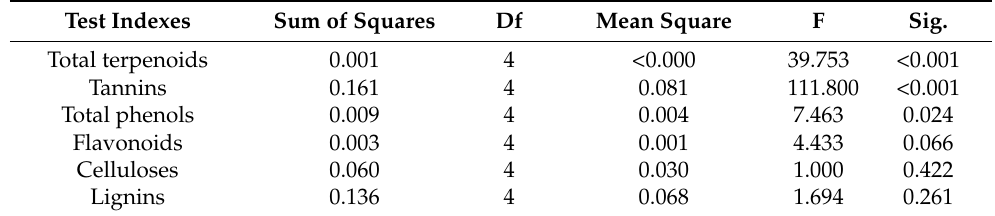
Table 1. One-way ANOVA of insect-resistant compounds in hazelnut shells of different hazel cultivars. Test Indexes Sum of Squares Df Mean Square Sig.